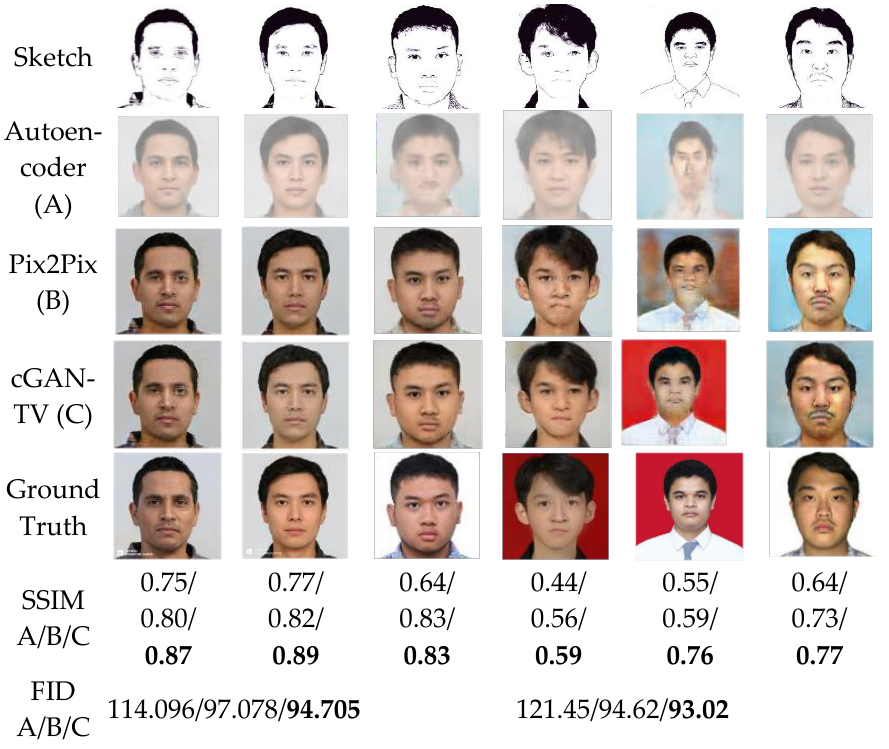
Figure 9. Our method with best scenario compared with cGAN (pix2pix) and autoencoder. The ground truth images are from generated photos [17] and volunteers (private collection).